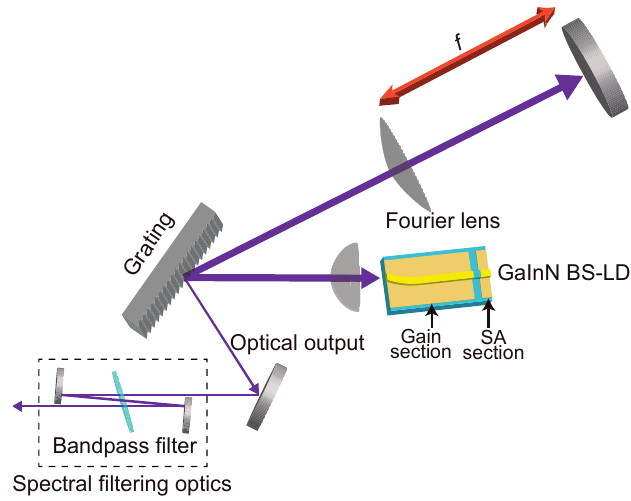
Figure 1. Schematic representation of dispersion-compensated GaInN MLLD including spectral filtering optics in order to obtain femtosecond optical pulses. Thick arrows represent the optical path of the external cavity configuration including GaInN BS-LD. The number of transmission through a bandpass filter was adjusted in order to obtain necessary